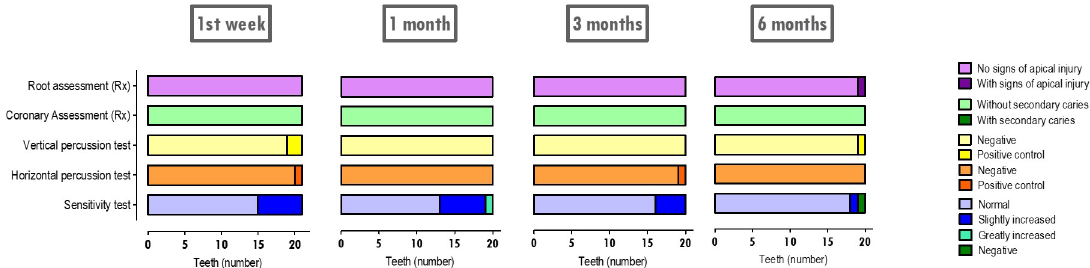
Figure 6. Therapeutic control times. Five parameters were analyzed: cold sensitivity tests (negative, normal, slightly increased, and greatly increased); horizontal and vertical percussion tests (negative and positive); coronary radiography (with or without secondary caries); root radiography (with or without apical lesion). The results express the evaluation of 21 teeth at 1 week and the evaluation of 20 teeth at 1 month, 3 months, and 6